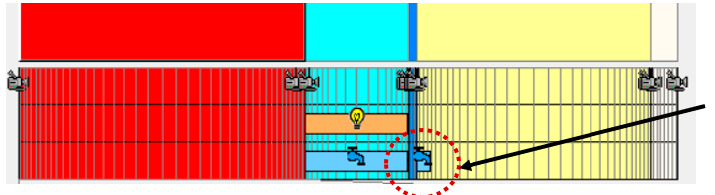
Figure 8. Example of a typical code ‐ compliant clay masonry veneer wall—with a moisture source added inside the pliable membrane layer.